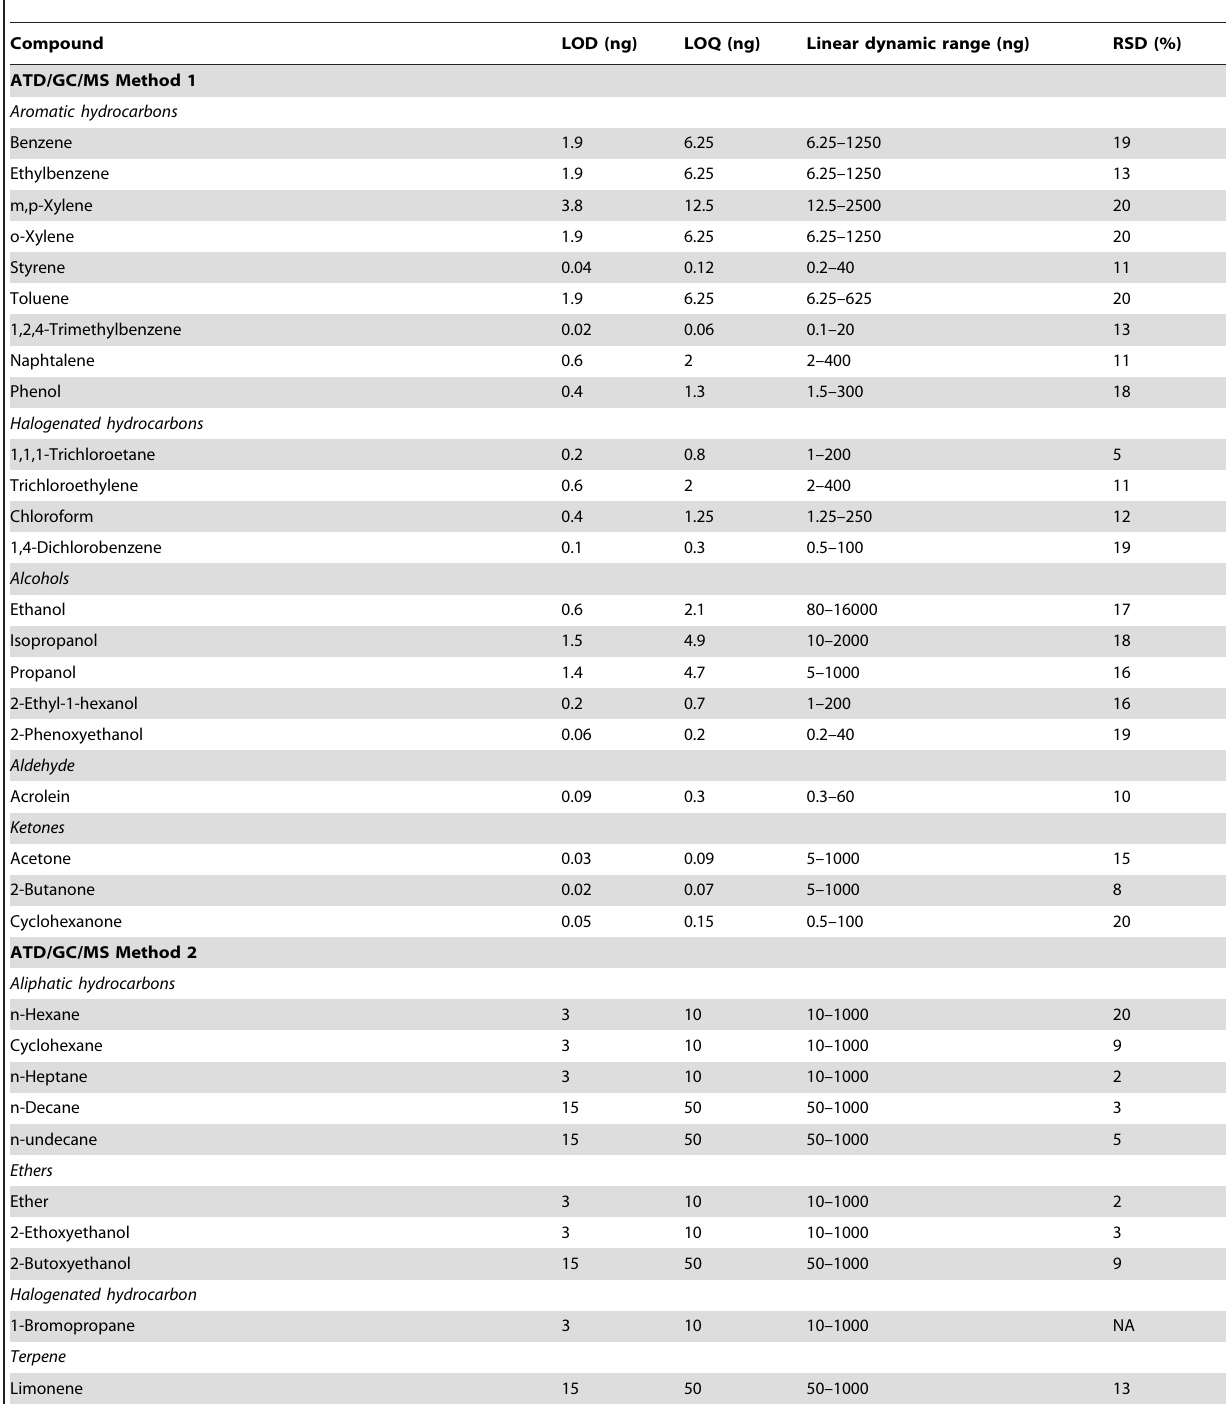
Table 2. Limit of detection (LOD), limit of quantification (LOQ), linear dynamic range and precision (% RSD) of the analytical methods